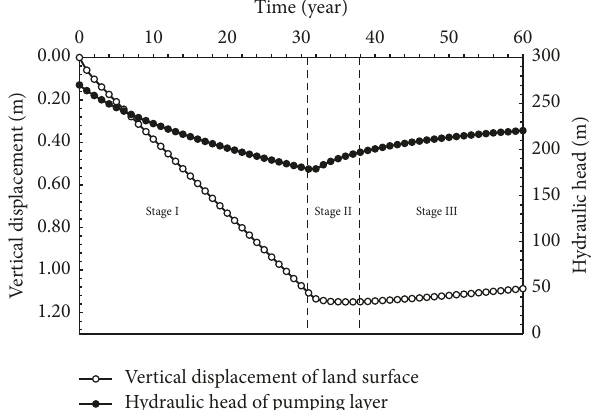
Figure 2: Simulated land surface vertical displacement corresponds to changes in hydraulic head of the confined aquifer II. In Stage I, the hydraulic head in the pumped layer drops and the land surface subsides.InStageII,thehydraulicheadinthepumpedlayerrecovers rapidly and the land subsidence ceases gradually and reaches a stable state. In Stage III, the hydraulic head in the pumped layer recovers slowly and the land surface